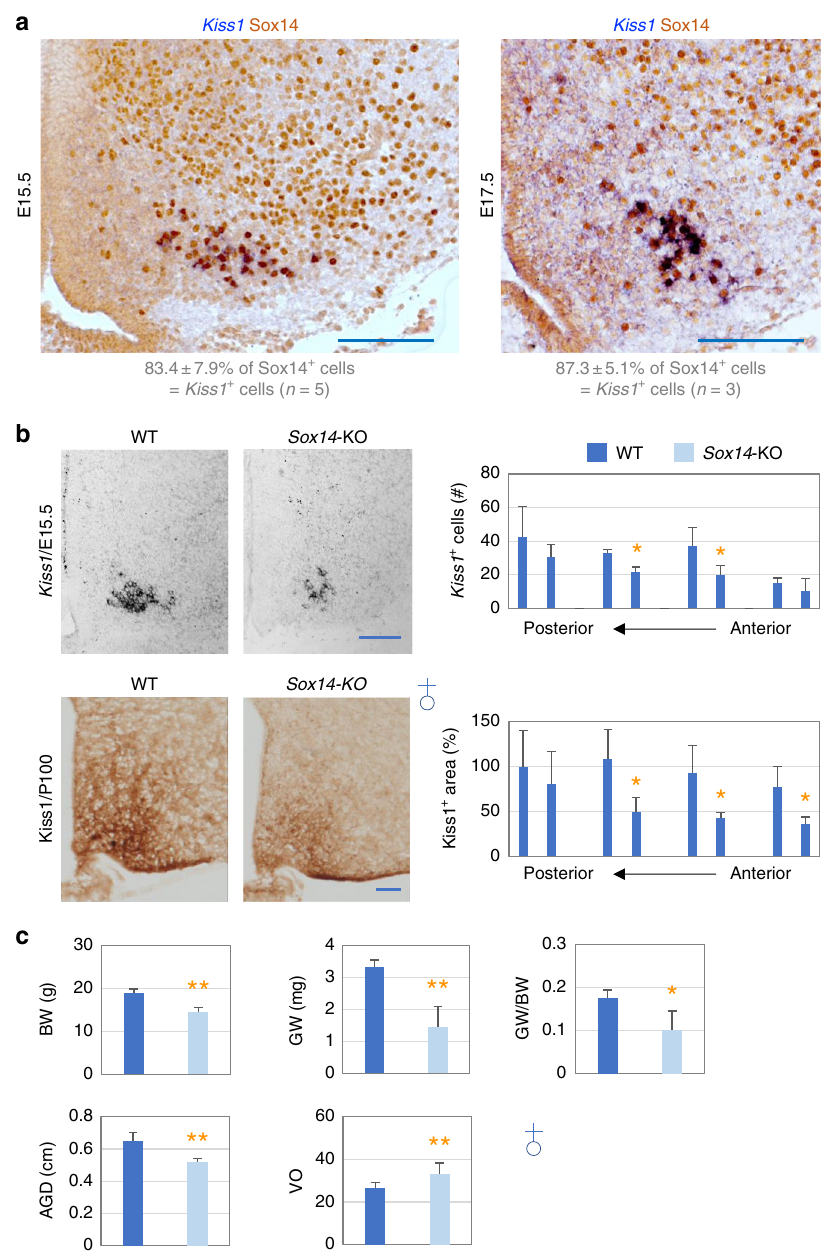
Fig. 6 Critical roles of Sox14 in the development of Kisspeptin-neurons. a ISH for Kiss1 (blue) combined with IHC against Sox14 (brown) reveal co- expression of Sox14 with Kiss1 in E15.5 and E17.5 ARC. b Signi fi cantly reduced expression of Kiss1 mRNA in the ARC of E15.5 embryos (ISH) and Kiss1 protein in the ARC of P100 female control and Sox14 -KO mice (IHC). Serial anterior-posterior sections are apart from each other by ~120 μ m, and the images shown are for the second anterior sections. c Body weight measurement, as well as assessment of reproduction phenotypes, GW (for gonad weight), AGD (for anogenital distance) and VO (for vaginal opening), for P100 female mice. The number of mice per each genotype was 3 – 15. All scale bars are for 100 μ m. Statistical differences were determined by Student ’ s t -test ( b , c ); p < 0.05 (one asterisk) and p < 0.01 (two